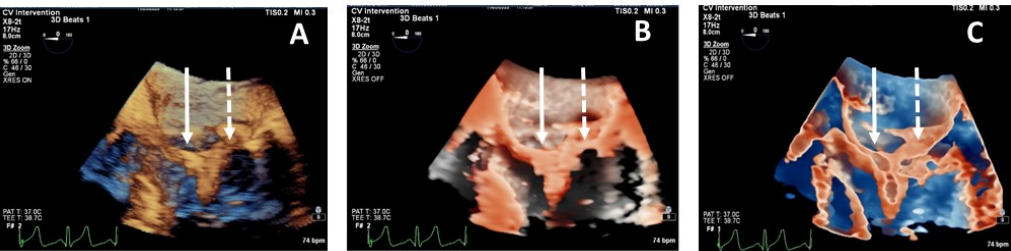
Figure 7. Head-to-head comparison among standard 3DTEE rendering panel ( A ), transillumination panel ( B ) and transparency panel ( C ) in clip grasping evaluation. Only transparency rendering allows one to visualize that anterior leaflet is well grasped (arrow) while the posterior leaflet (dotted arrow) has not been captured correctly and it appears short and folded into the arms of the clip.